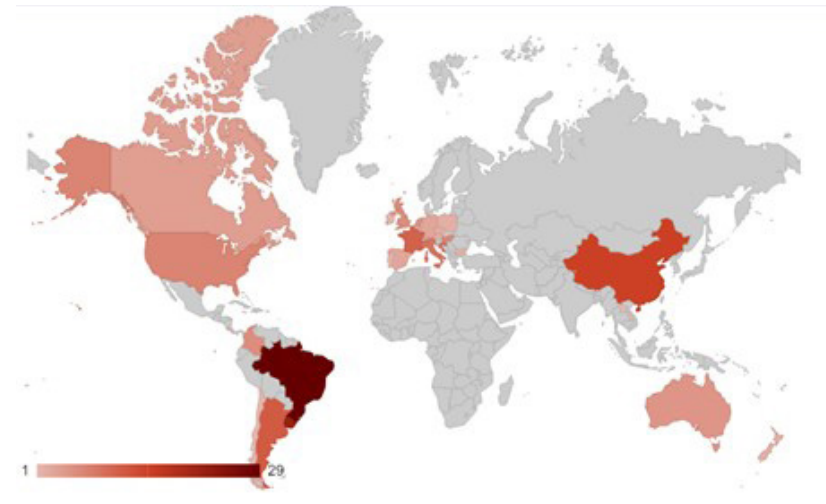
Figure 2. The distribution of the countries in the global scientific production between 2010 and 2018, referring to Kruk et al.